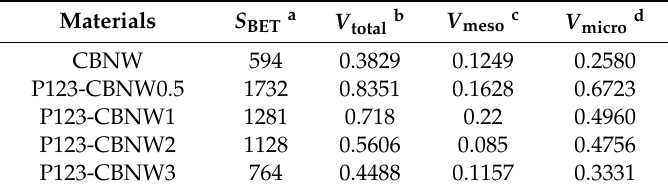
Table 2. Textural properties of prepared materials from N 2 isotherms at 77